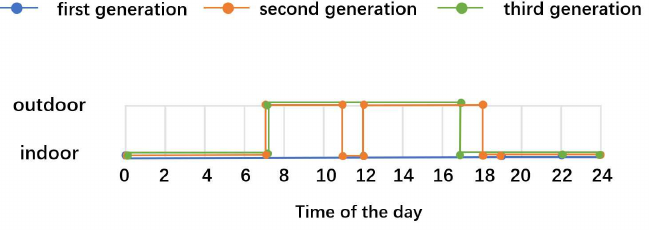
Figure 6. Time schedule of lighting being on/off.